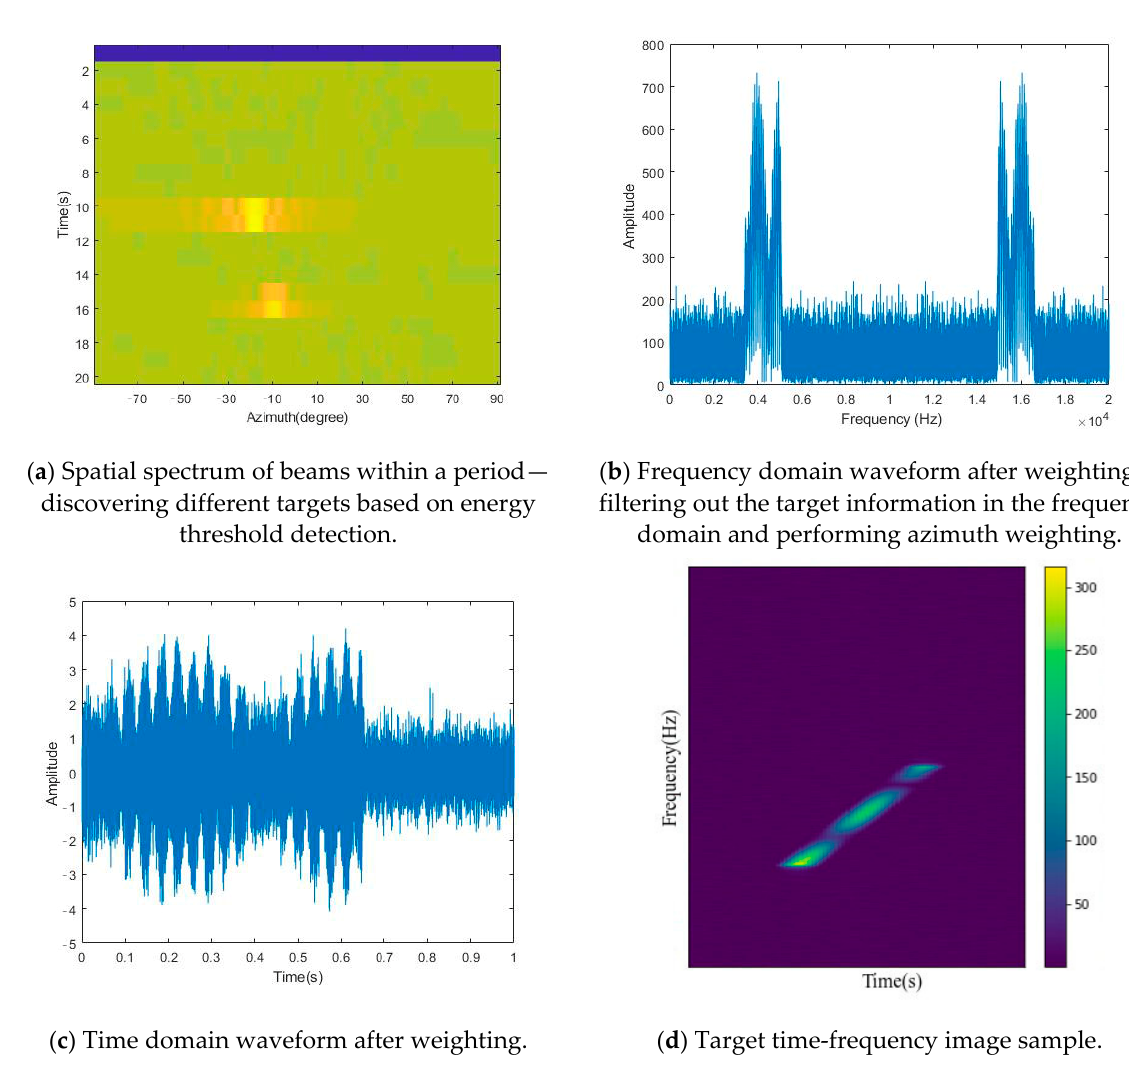
Figure 3. Time-frequency images related to the target’s azimuth.